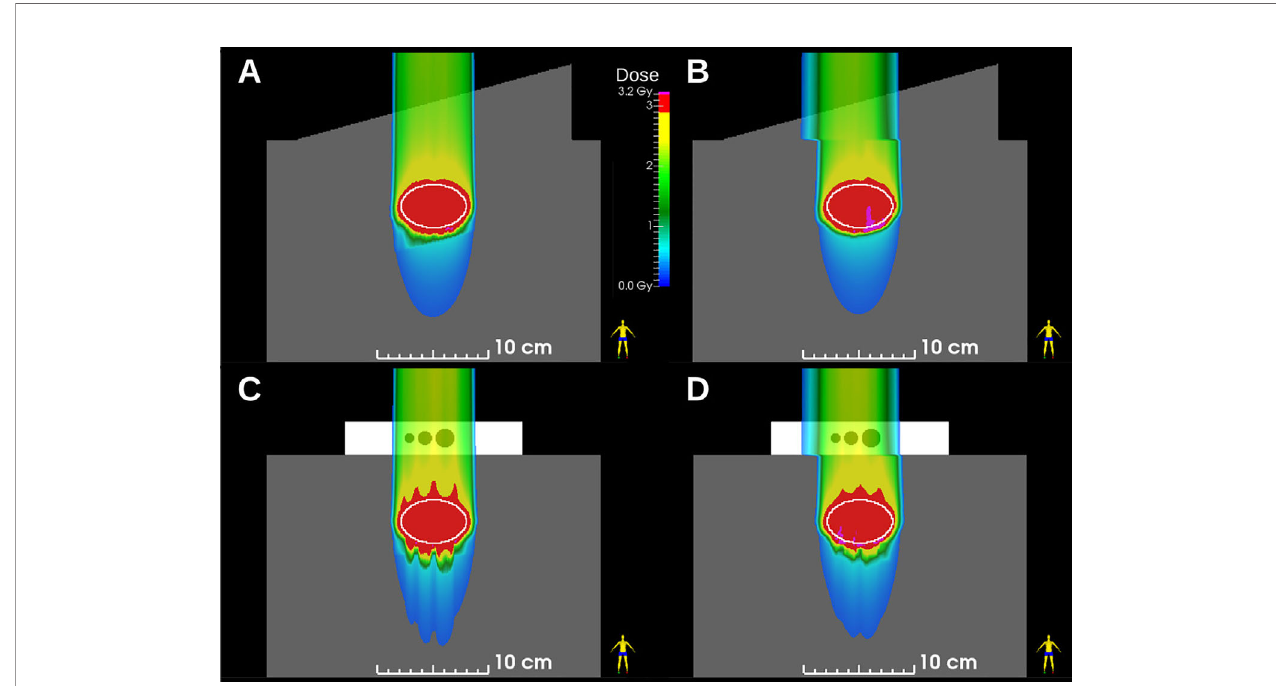
FIGURE 6 | Dose distributions in ellipsoid targets (white ovals) for (A) static and (B) 10-phase multi-phase dose deliveries through the wedge phantom and for (C) static and (D) 10-phase multi-phase 4D deliveries through the density phantom. Plans were robustly optimized and deliveries were reconstructed from beam delivery log fi les and motion monitoring log fi